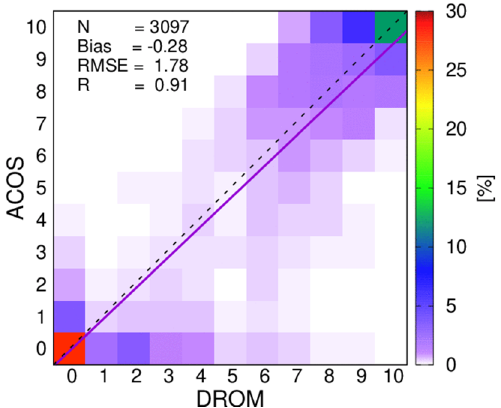
Figure 5. Tenth cloud cover scatterplot of ACOS and DROM for all the cases in 2019. The dotted line represents the 1:1 line and the solid line the regression line. R is the correlation coefficient. N is the number of cases.